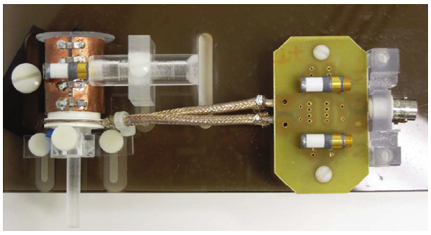
Figure 2: The RF coil and